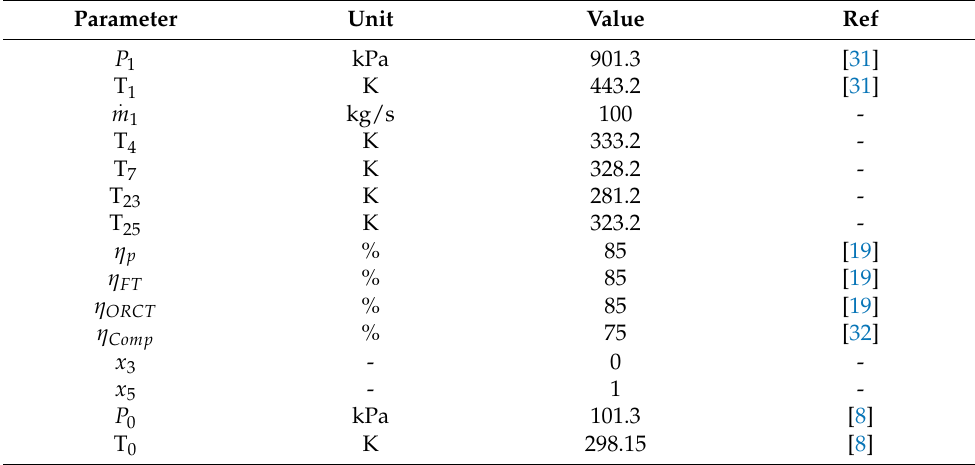
Table 1. Input parameters in thermodynamic